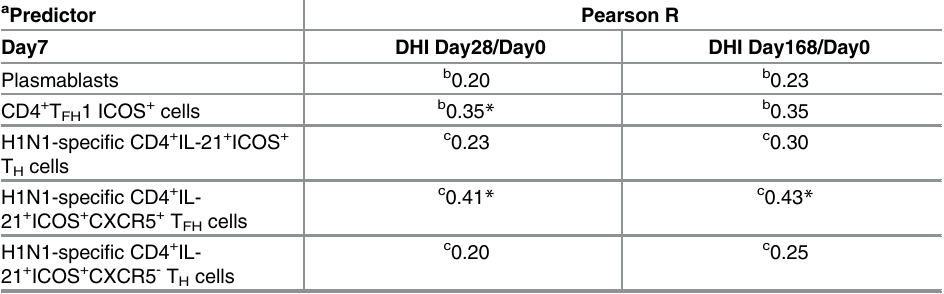
Table 1. Correlation between cell subsets and DHI